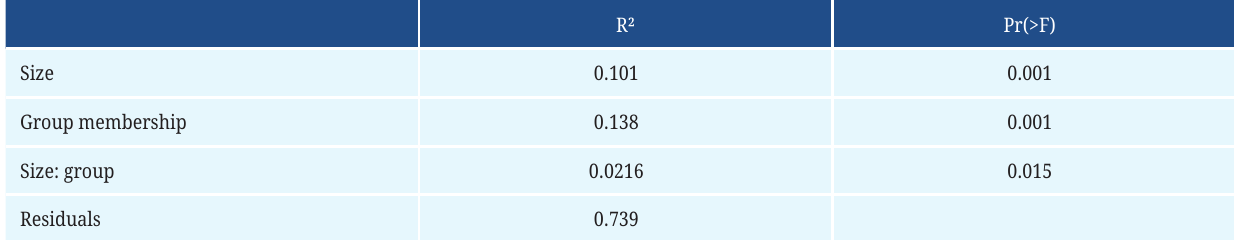
TABLE 1 | Results for multivariate regression of body shape on size and group